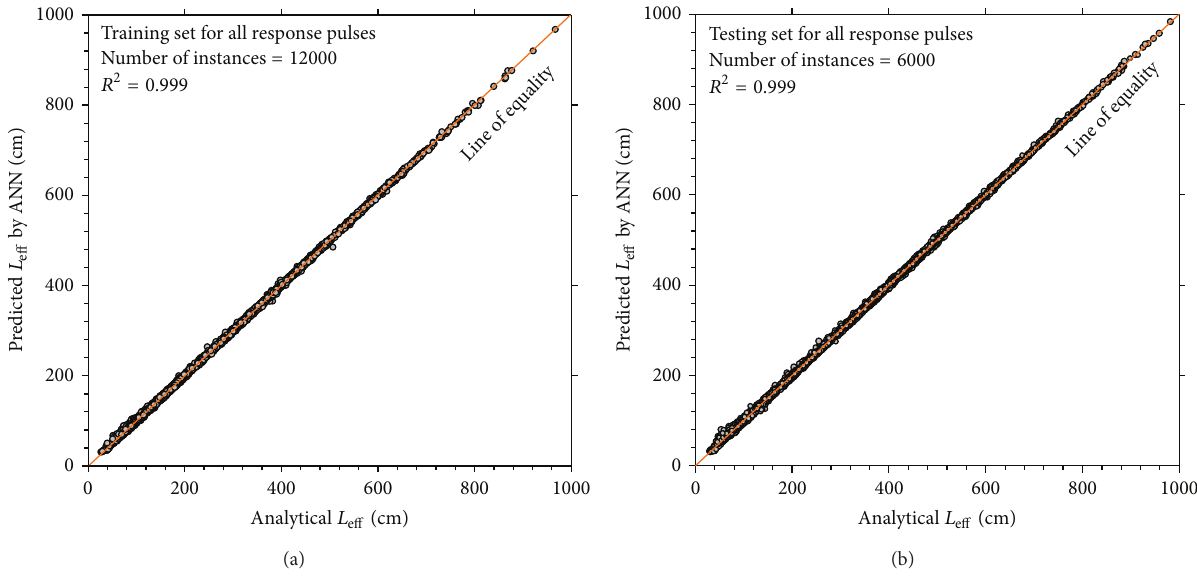
Figure 8: Performance of ANN for predicting effective length (𝐿